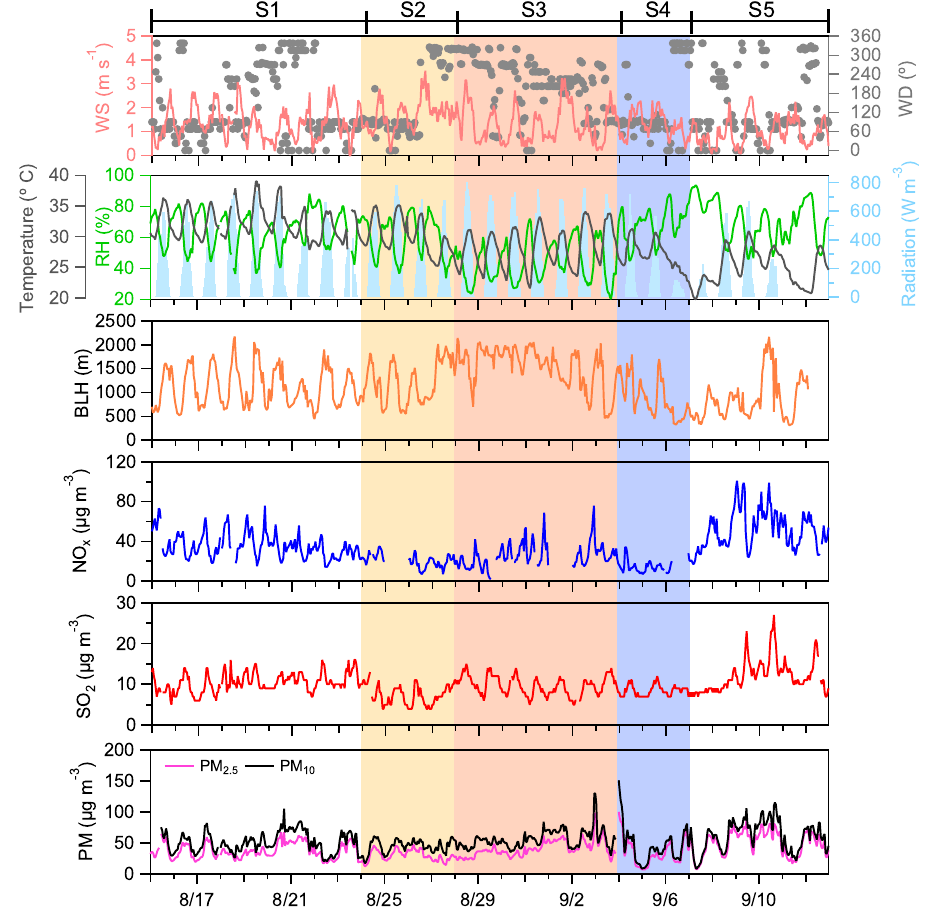
Figure 2. Time series of hourly PM 2 . 5 and PM 10 concentrations, trace gases (NO x , SO 2 ), and meteorological parameters (wind speed – WS, wind direction – WD, boundary layer height – BLH, relative humidity – RH, temperature – T , and radiation). The five defined stages from S1 to S5 are marked at the top of the figure. S1 was the reference stage, S2 was the stage with industrial and construction emission control, S3 was the stage with added restrictions on motor vehicles, S4 was the G20 summit period, and S5 was the post-G20 stage. The missing data in Fig. 2 are due to the malfunction or maintenance of the